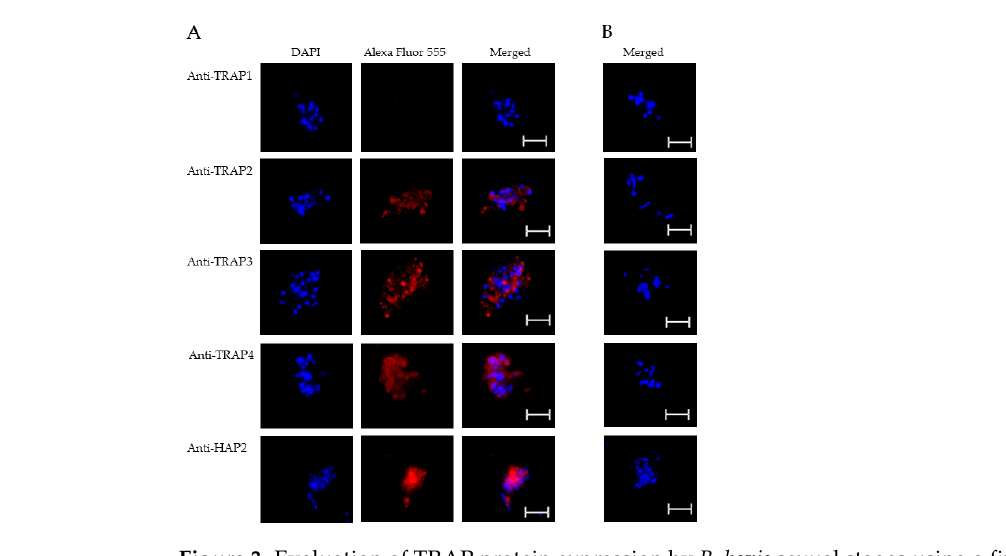
Figure 2. Evaluation of TRAP protein expression by B. bovis blood stages using a fixed immunofluorescence assay incubated with anti-TRAP 1, 2, 3, 4 or HAP2. Panels are ( A ) immune and ( B ) pre-immune rabbit serum. Blue indicates DAPI stained DNA and red indicates anti-rabbit IgG Alexa Fluor 555 reactivity. Scale bar: 5 µm.